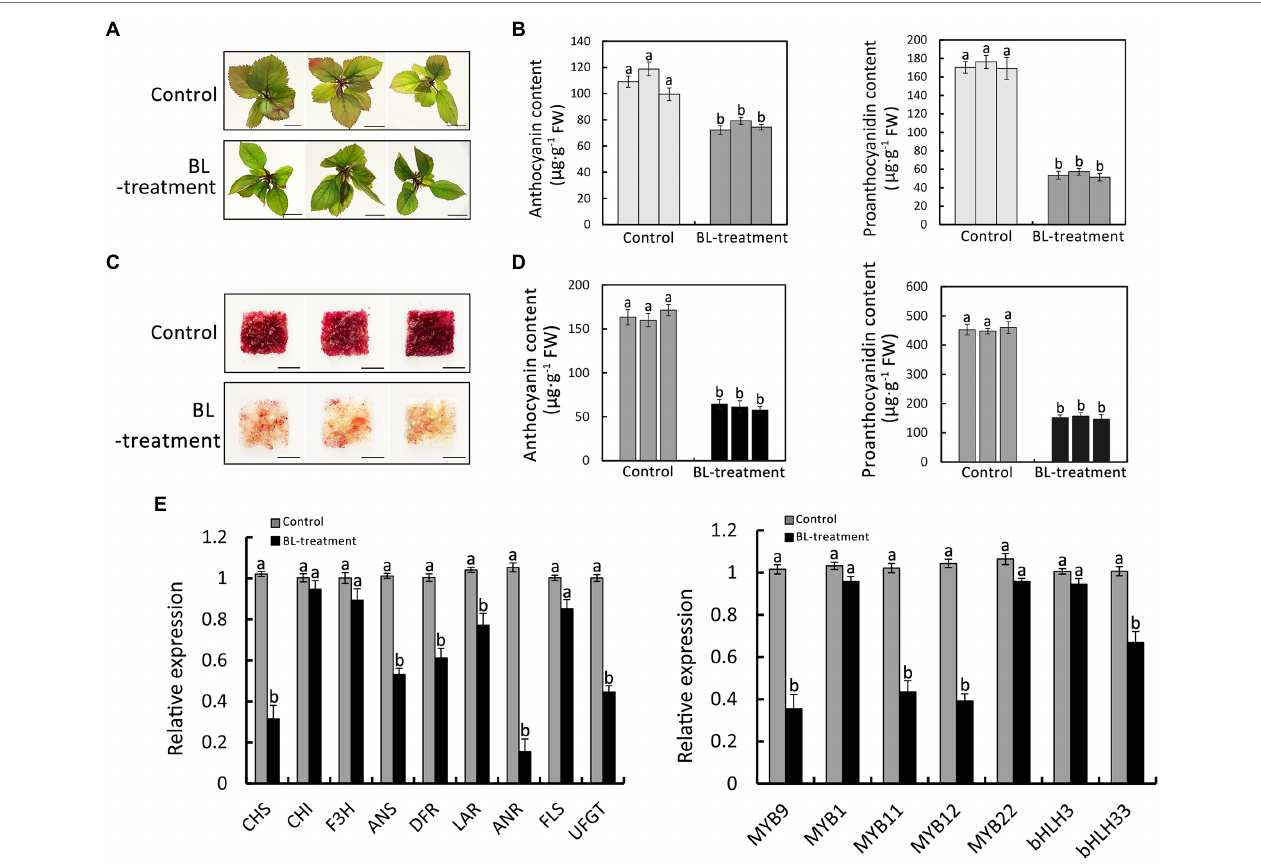
FIGURE 1 | Effect of BR on the biosynthesis of anthocyanin and proanthocyanidin in red-fleshed apple seedlings and calli. (A) Phenotype of red-fleshed apple seedlings treated with 1 μ M BL for 7 days. Scale bar = 1 cm. (B) Anthocyanin and proanthocyanidin contents in red-fleshed apple seedlings. (C) Phenotype of red- fleshed apple calli treated with 1 μ M BL for 14 days. Scale bar = 1 cm. (D) Anthocyanin and proanthocyanidin contents in red-fleshed apple calli. (E) Results of the qRT-PCR analysis of the expressions of flavonoid synthesis-related genes in red-fleshed apple seedlings after the BL treatment. Statistical significance is indicated by different lowercase letters ( p < 0.05